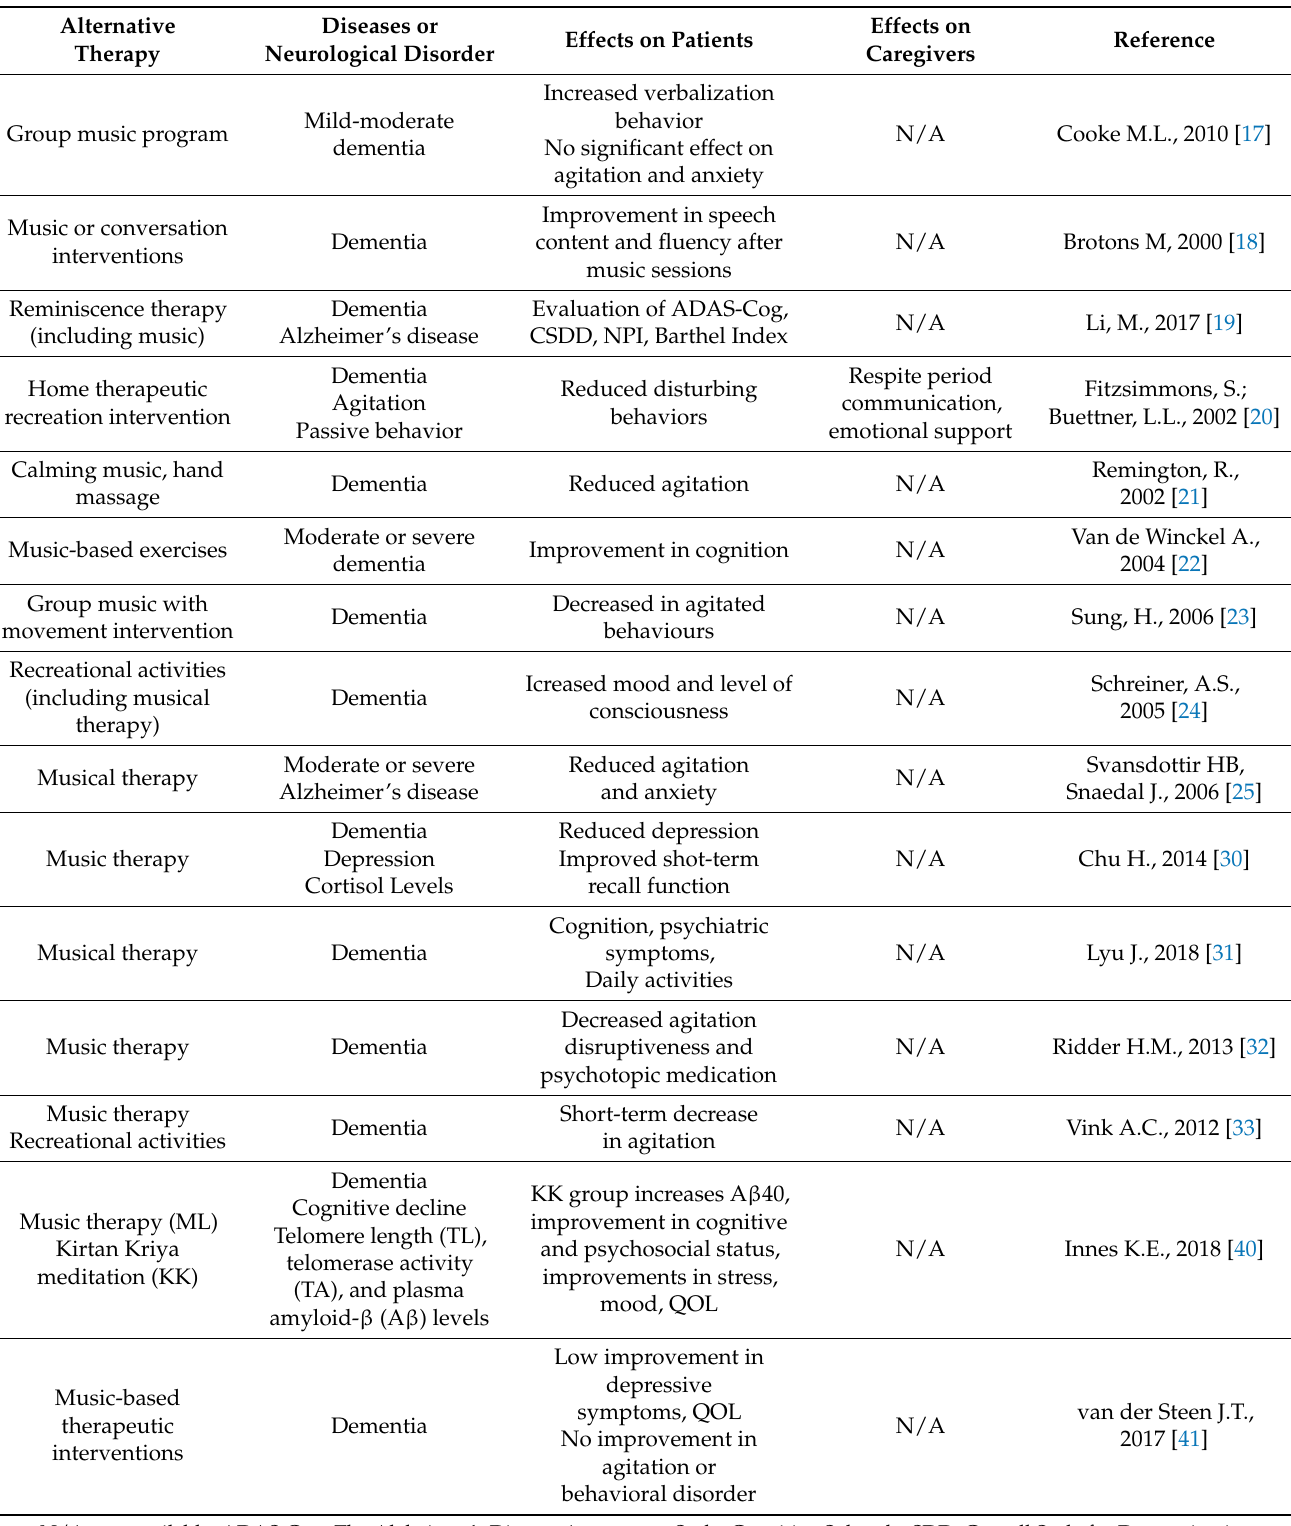
Table 1. Relevant studies for musical